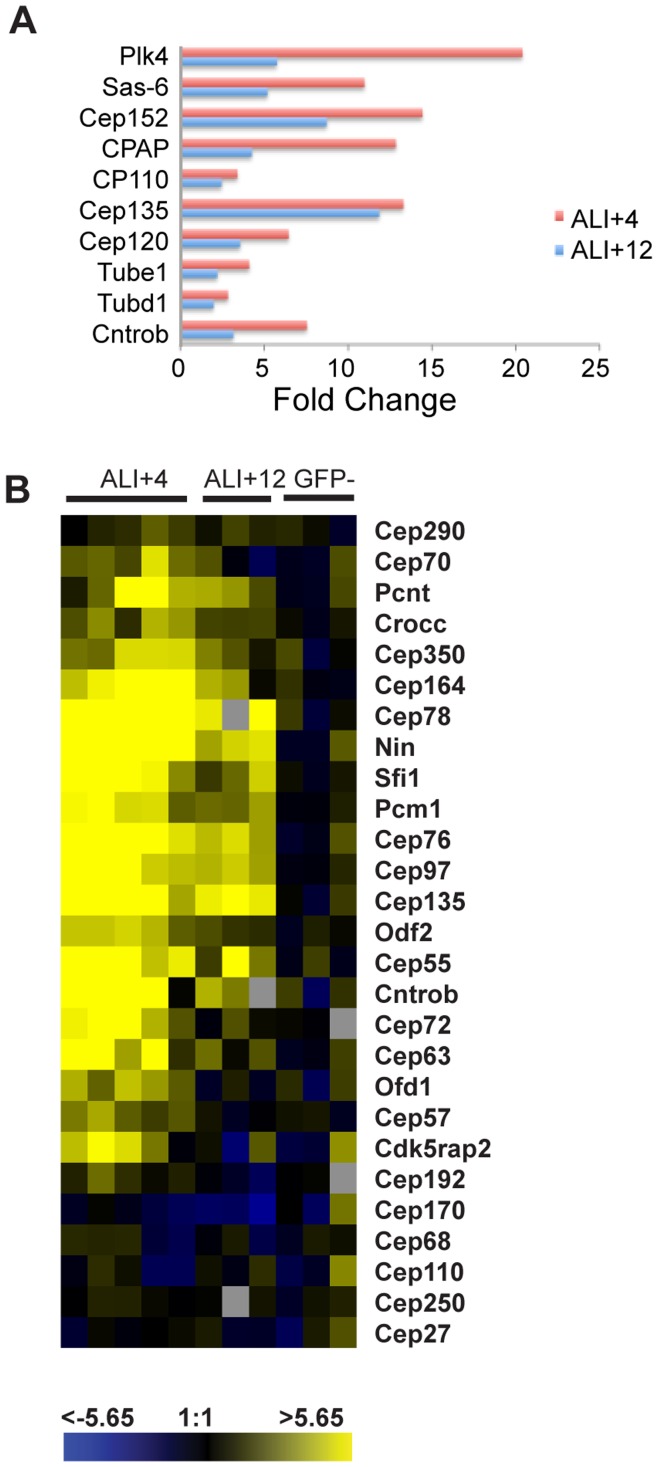
Genes encoding centrosome proteins are differentially regulated during basal body formation.(A) Upregulation of regulatory and structural proteins required for centriole duplication in cycling cells and (B) heat map of putative and known centrosomal components. Genes are shown in rows and replicate arrays are shown in columns. Three biological replicates were performed for ALI+4, ALI+12 and GFP-. In addition, two technical replicates were performed for two of the ALI+4 biological replicates (columns 1,2 and 4,5) for a total of five columns. Data were zero-transformed against non-ciliated (GFP-) cells. The scale indicates the fold change in expression (log2). Grey boxes represent gene spots that failed to pass quality control filters for the indicated array.